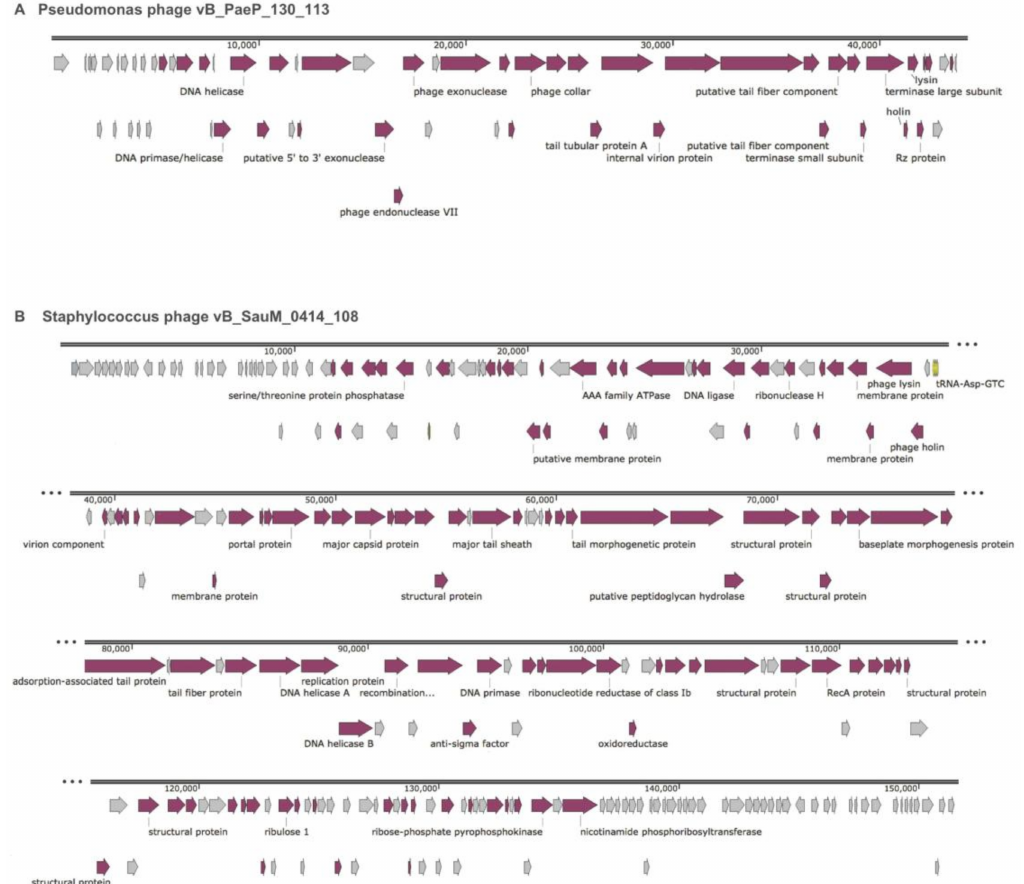
Figure 3. Whole genome maps for finished annotated phage genomes. Annotations for selected predicted open reading frames (ORFs) are presented for Pseudomonas phage vB_PaeP_130_113 ( A ); and Staphylococcus phage vB_SauM_0414_108 ( B ). Mauve colored arrows indicate the ORF has been annotated; grey colored arrows indicate ORFs annotated “hypothetical”; yellow arrows indicate